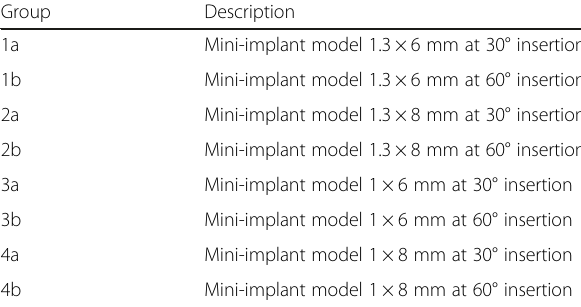
Table 2 List of FE models and